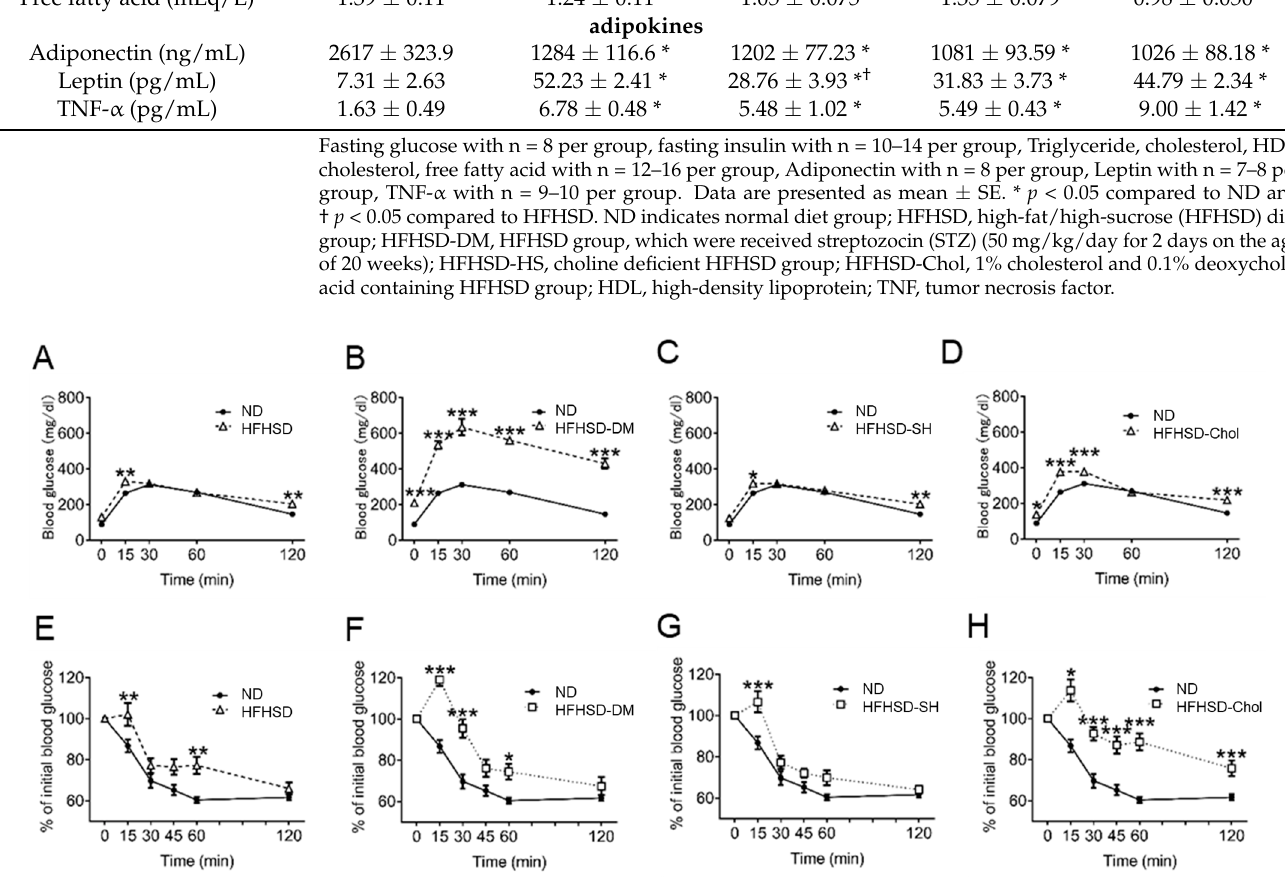
Figure 1. All the HFHSD groups revealed higher glucose levels and insulin resistance, and the HFHSD-DM group, in particular, showed the highest levels of glucose: ( A – D ) Oral glucose tolerance test (OGTT) time curve for glucose levels (n = 8); ( E – H ) insulin tolerance test (ITT) time curve for glucose levels (n = 8). OGTT and ITT are expressed as mean blood glucose levels ± standard error of the mean (SEM). ND, normal diet group; HFHSD, high-fat/high-sucrose (HFHSD) diet group; HFHSD-DM, HFHSD group that received streptozocin (STZ) (50 mg/kg/day for 2 days at 20 weeks old); HFHSD-SH, choline-deficient HFHSD group; HFHSD-Chol, 1% cholesterol and 0.1% deoxycholic acid-containing HFHSD group. * p < 0.05, ** p < 0.01, and *** p < 0.001 compared with the ND group. Table 2. Serum glucose and lipid metabolic parameters and adipokines.